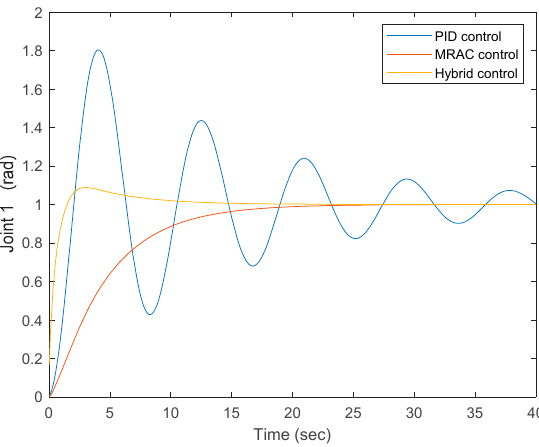
Figure 12. Joint output under three controls—scenario 2.